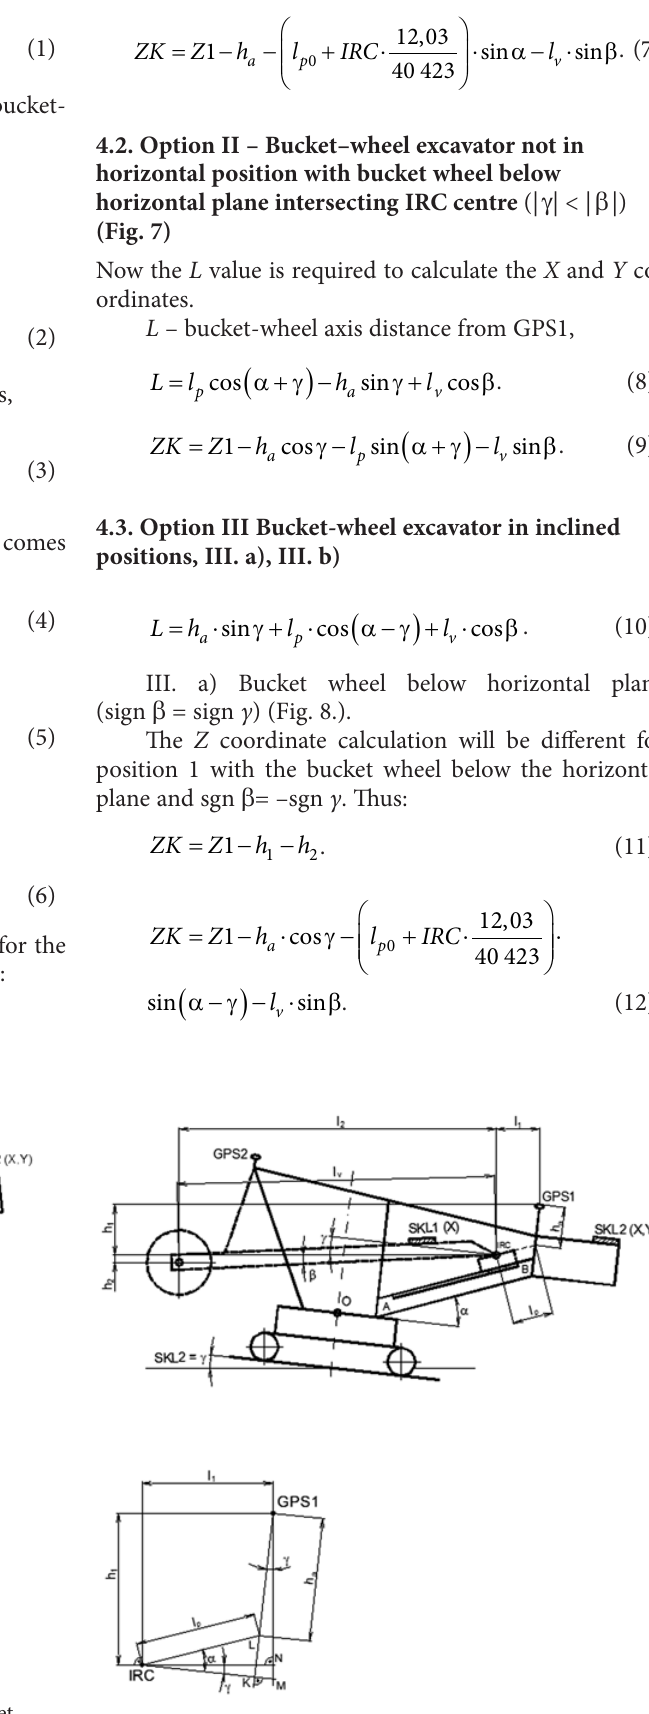
Fig. 7. Inclined bucket-wheel excavator with bucket wheel below IRC plane (| γ | < | β |) and IRC joint detail image